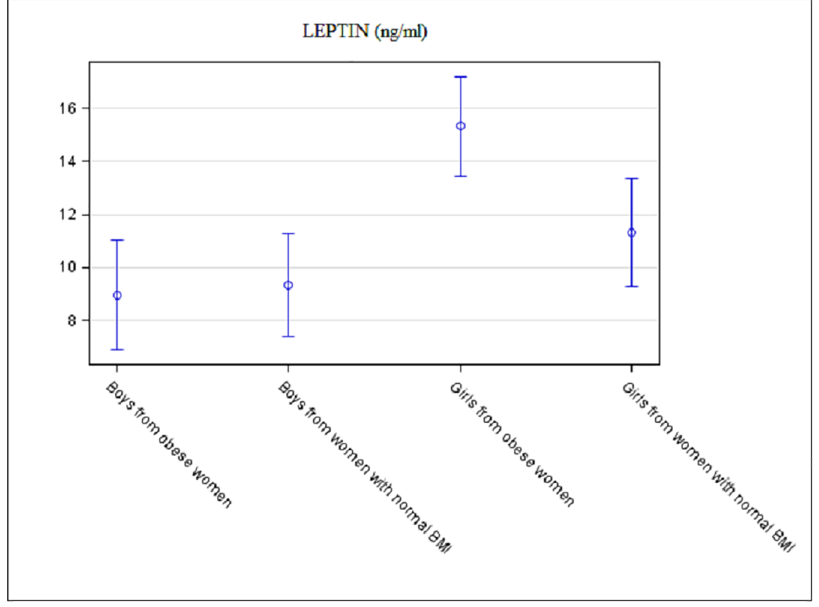
Fig 3. Adjusted neonatal cord leptin concentration according to maternal BMI and according to the sex of the neonate. Data are mean with 95% confidencelimits.